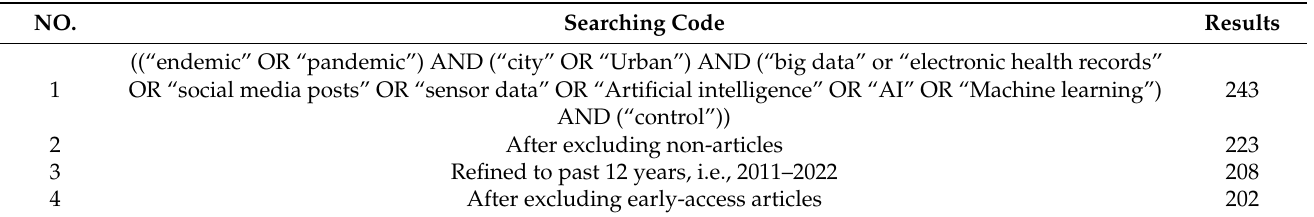
Table 1. Searching codes used and results obtained throughout the data extraction process from WOS. Searching